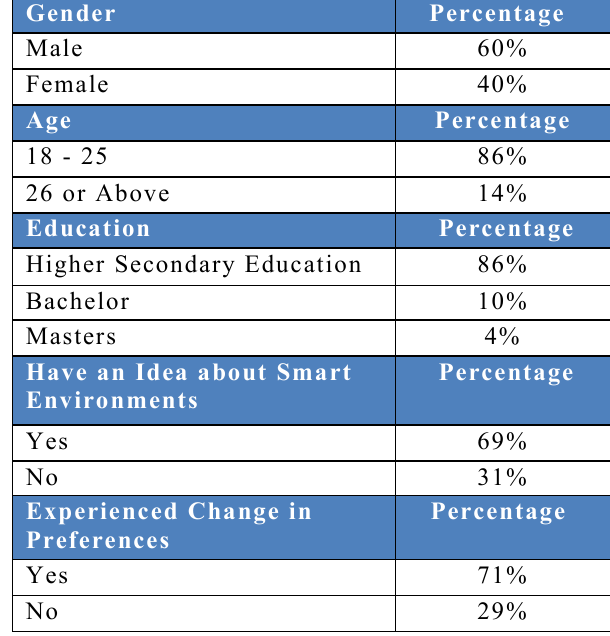
Table 1. Participants’ Demographic